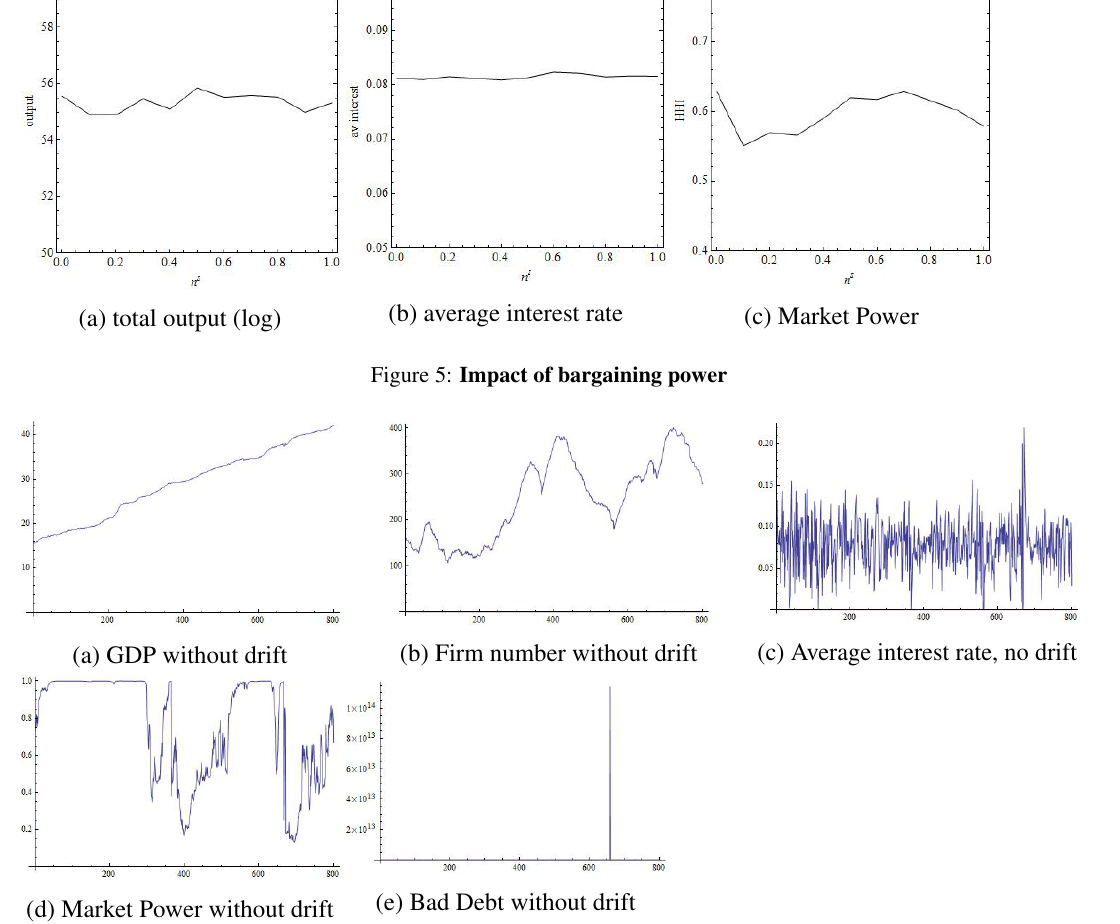
Figure 6: Time series for high bargaining power of